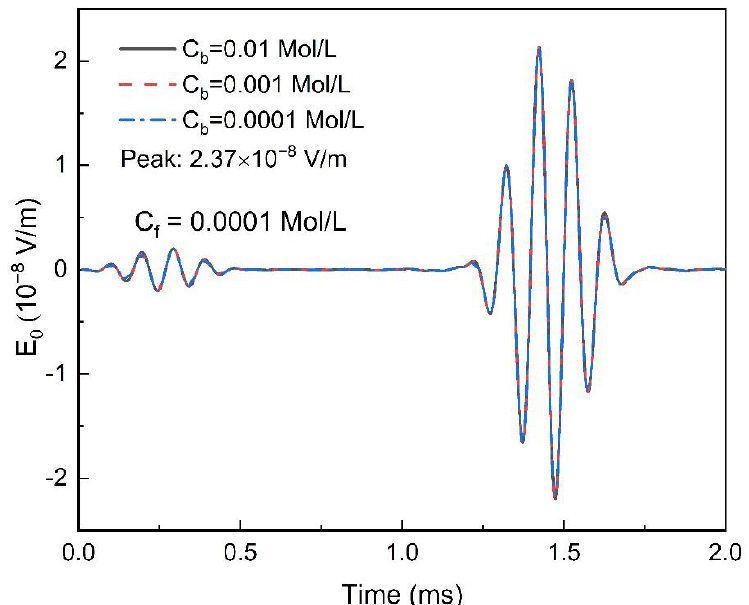
Figure 4. Electric fields for different levels of borehole fluid salinity. The solid line, dashed line, and dot-dashed line correspond to the salinity 𝐶 𝑏 = 0.01 Mol/L,0.001 Mol/L,0.0001 Mol/L , respective- ly.